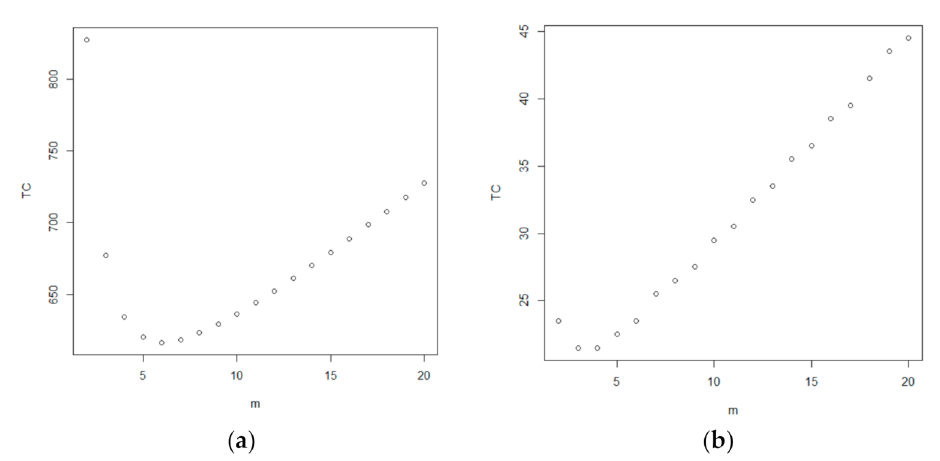
Figure 5. ( a ) Total cost curve at m = 2(1) m 0 ; ( b ) total cost curve at m = 2(1) m 0